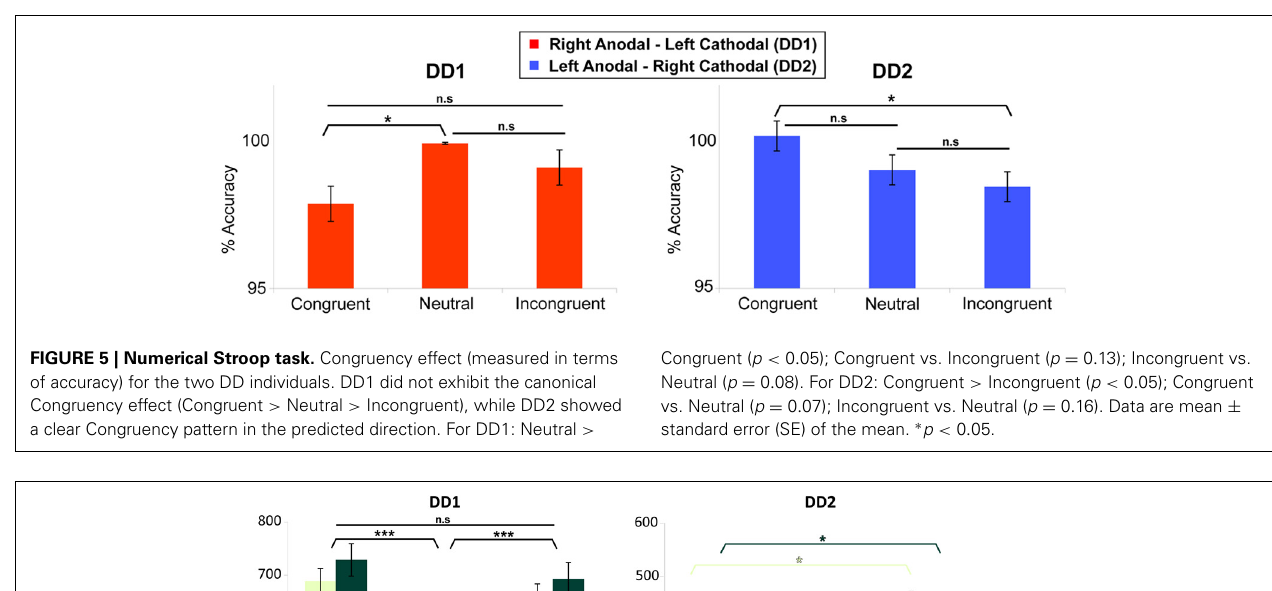
FIGURE 6 | Numerical distance by congruency effects. Effects measured in terms of RTs for each DD individual. DD1 did not exhibit the canonical Congruency effect (Incongruent > Neutral > Congruent), while DD2 showed a Congruency pattern related to the numerical distance between stimuli. For DD1 both Congruent as well as Incongruent trials were slower than Neutral trials ( p < 0 . 001) and no effect of numerical distance was evident [ F < 1]. In DD2, the canonical